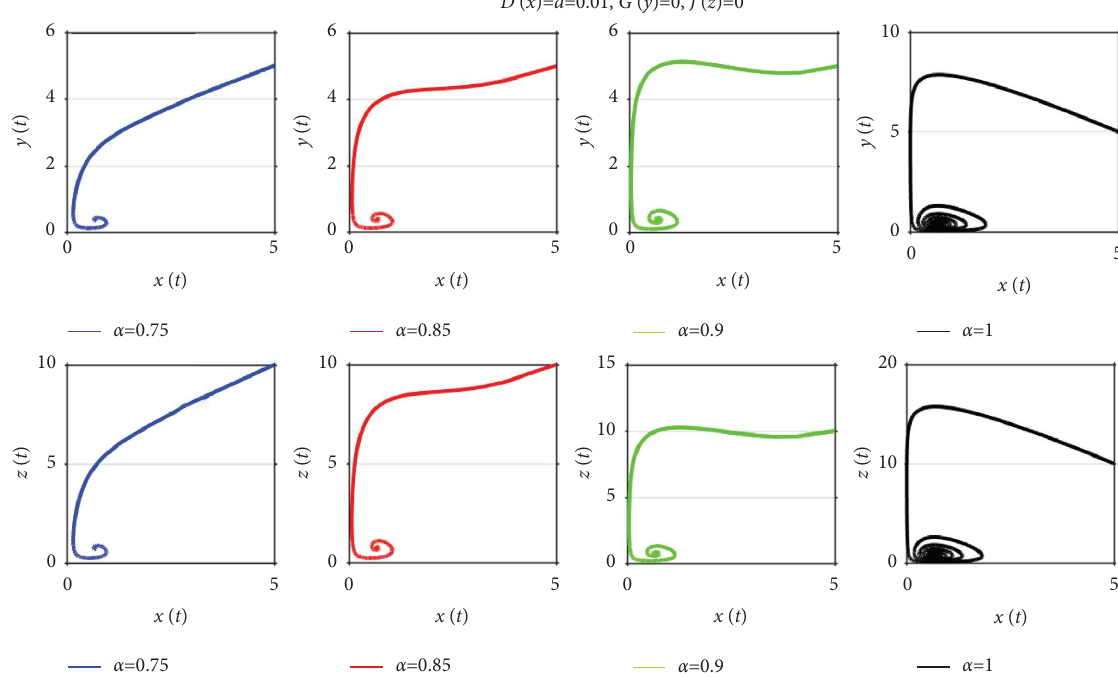
Figure 5: Phase space for the one prey-two predators system, where D ( x ) � d � 0 . 01 , G ( y ) � 0 , J ( z ) � 0 ,a � b � c � 0 . 1 , e � h � 0 . 3 , f � i � 0 . 2 , and α � 0 . 75 , 0 . 85 , 0 . 9 , 1